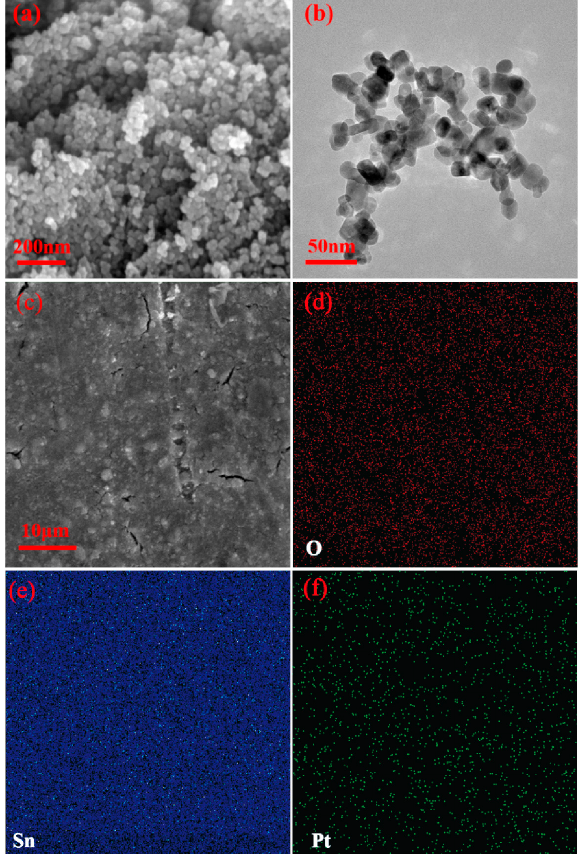
Figure 2. ( a ) SEM and ( b ) TEM images of SnO 2 ; ( c – f ) EDS mapping of Pt-SnO 2 .